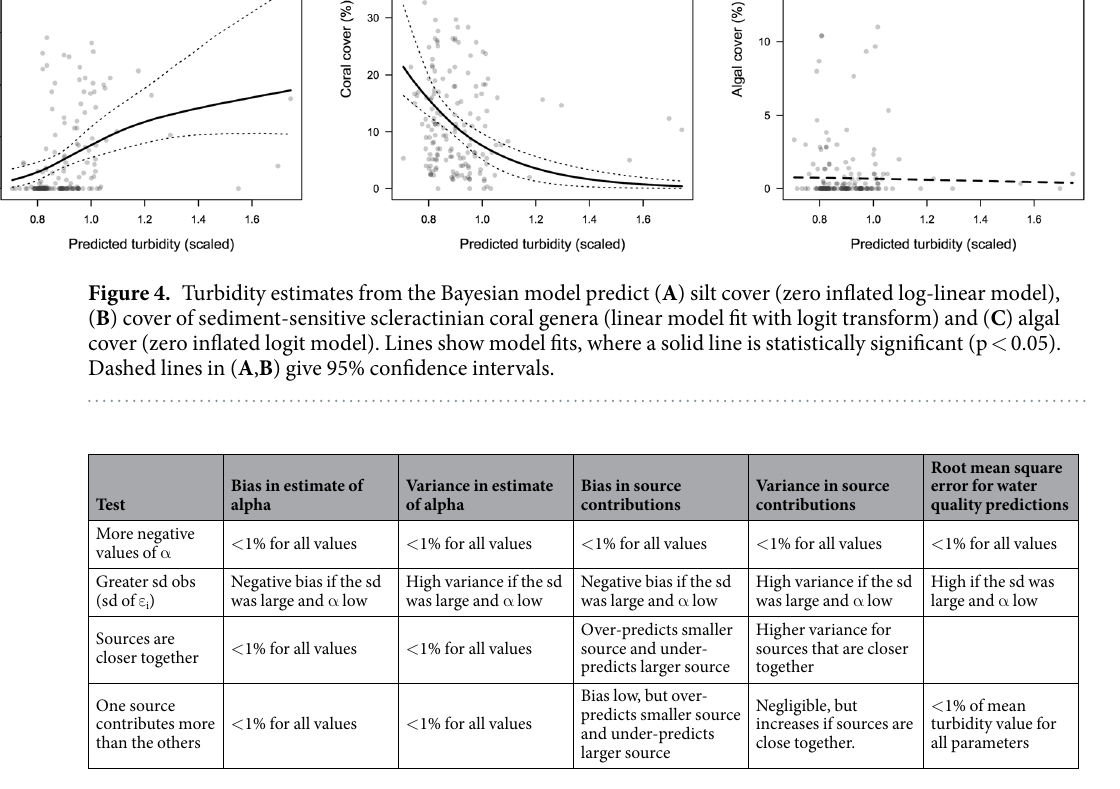
Table 2. Summary of results from varying parameters for simulating testing of the Bayesian